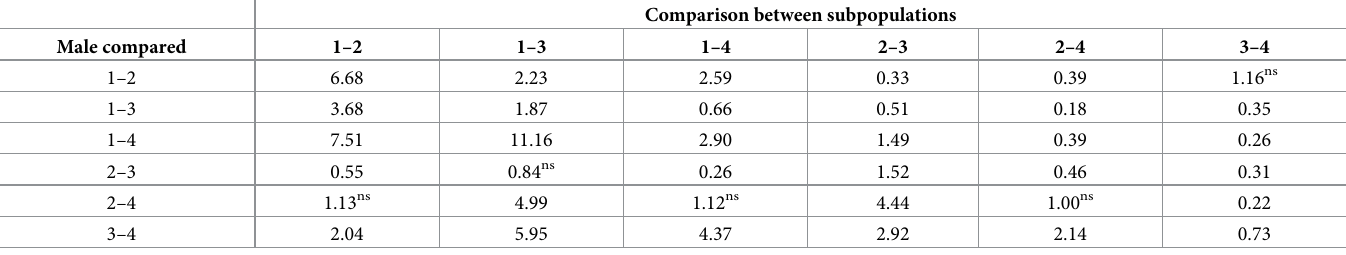
Table 7. Odds-ratio values of kinematic subpopulations based a pair-wise comparison among four American crocodile ( Crocodylus acutus ) males � . Comparison between